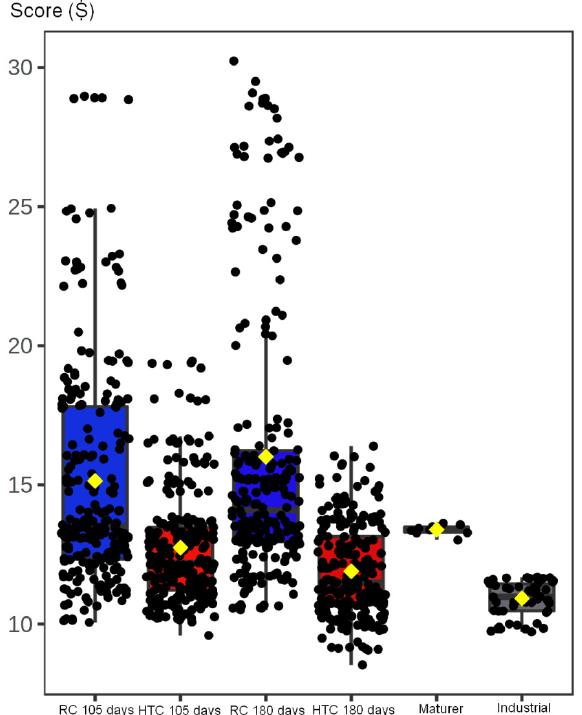
Figure 3. Box plots of the Score values ( Ṩ ) of each group of cheeses (RC, HTC, industrial and ma- turer cheeses).